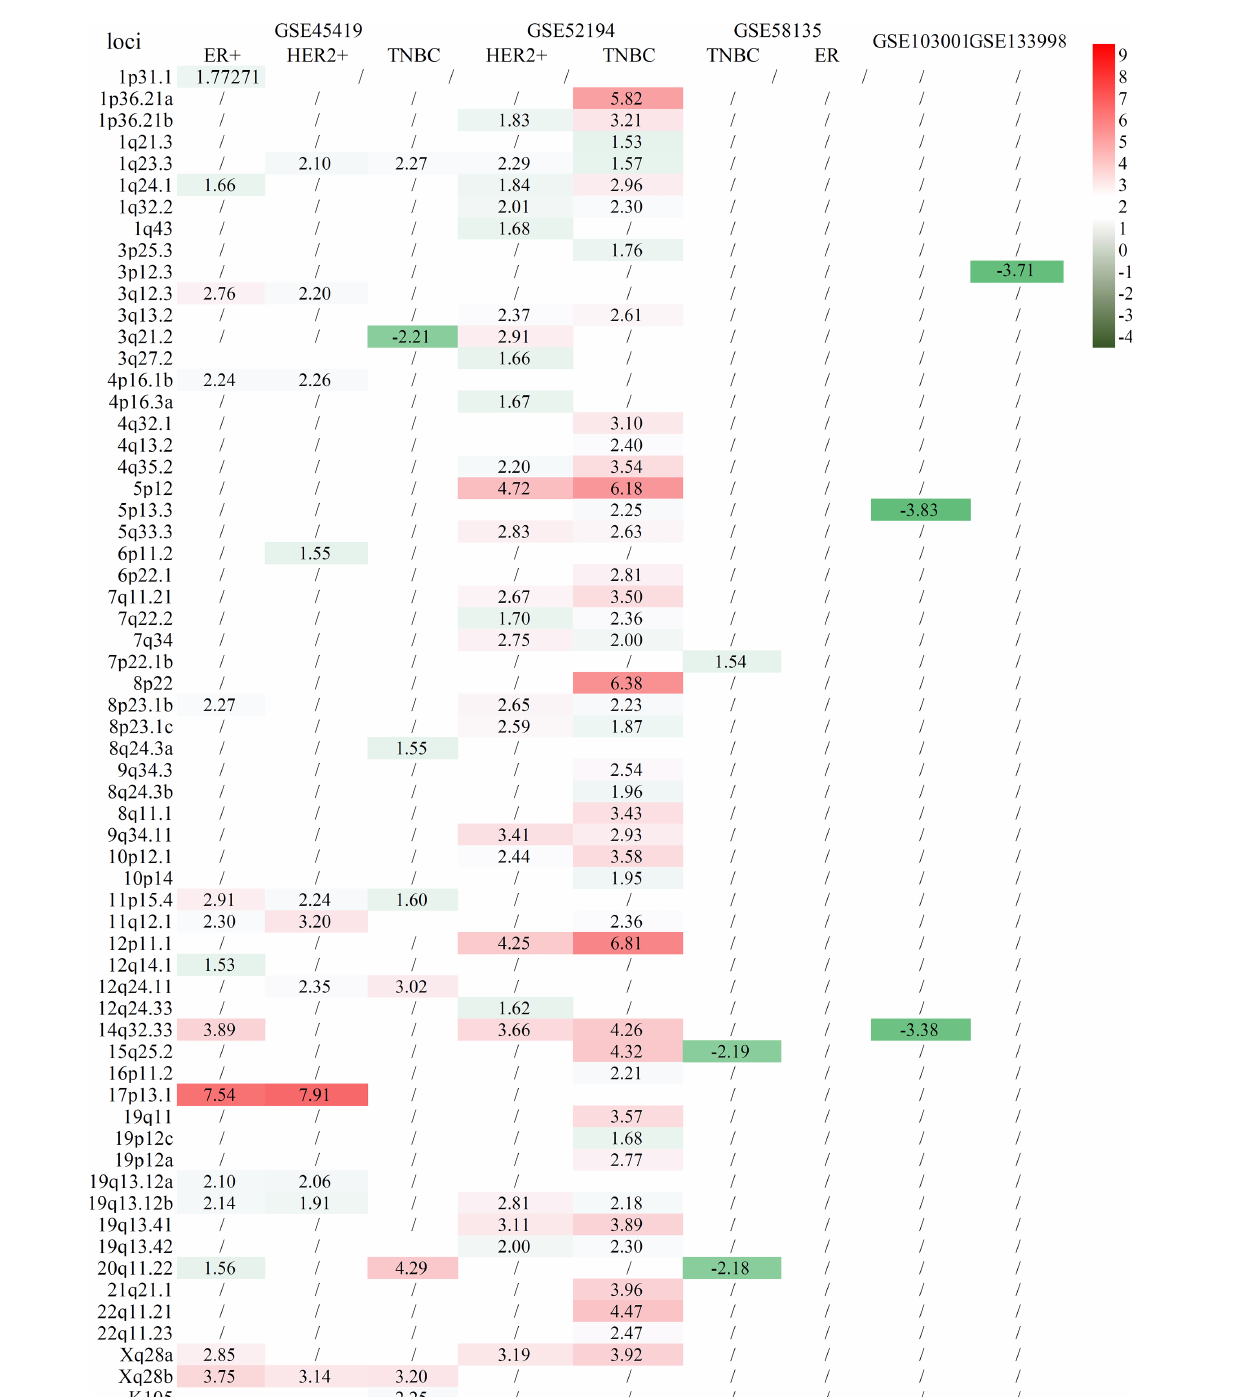
Frontiers in Oncology |